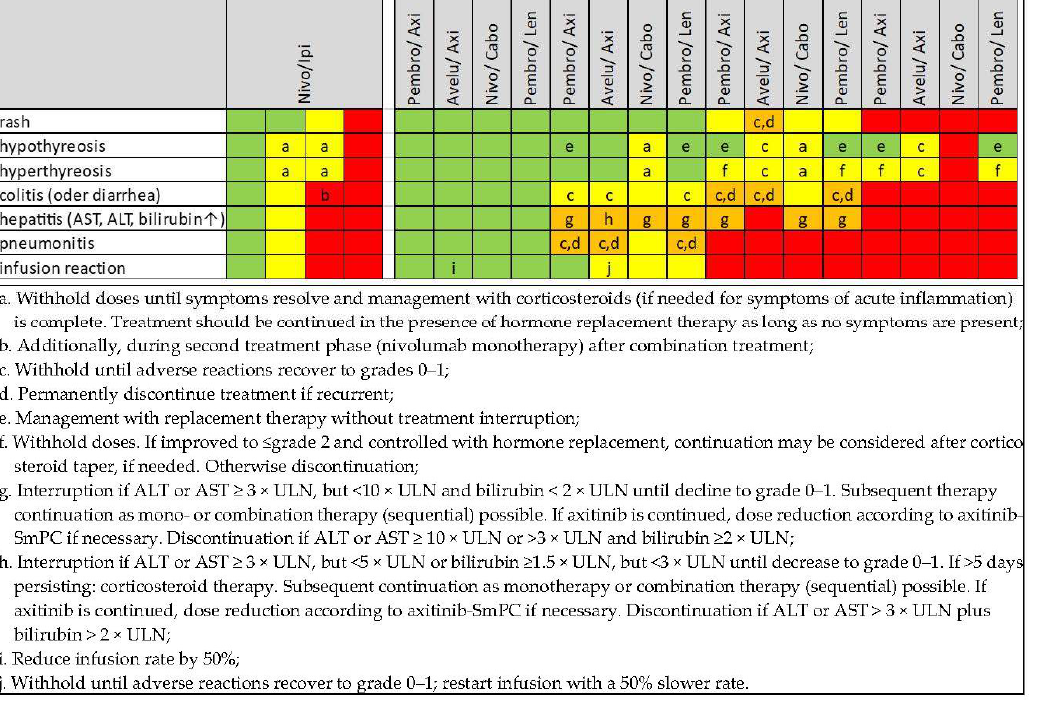
Figure 3. Recommendations for therapy management of immune checkpoint inhibitors (ICI) in ICI- based combination therapy depending on type and severity of important irAE. Green: continuation, yellow: interruption, orange: interruption or discontinuation under certain conditions, red: permanent discontinuation. Assessment based on the respective Summaries of Product Characteristics (SmPC) of the European Medicines Agency (EMA) (accessed 22 July 2022). (ir)AE, (immune-related) adverse event; ALT, alanine aminotransferase; AST, aspartate aminotransferase; Avelu, avelumab; Axi, axitinib; Ipi, ipilimumab; Lenva, lenvatinib; Nivo, nivolumab; Pembro, pembrolizumab; ULN, upper limit of normal range; ↑ , increased.